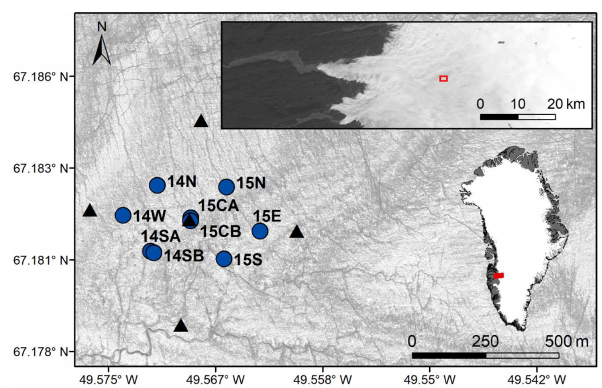
Figure 1. Map of the field location showing the layout of the nine boreholes (blue dots) and the five GPS stations (black triangles). Borehole nomenclature is determined by the year that they were drilled and the direction from the center borehole and GPS station. The boreholes are located ∼ 33km from the margin of Issunguata Sermia outlet glacier shown in a Landsat 8 image taken in July 2014 in the upper right inset. The location in southwestern Greenland is shown in the lower inset, and boreholes are plotted on a WorldView- 2 image from July 2012 (© DigitalGlobe, Inc.